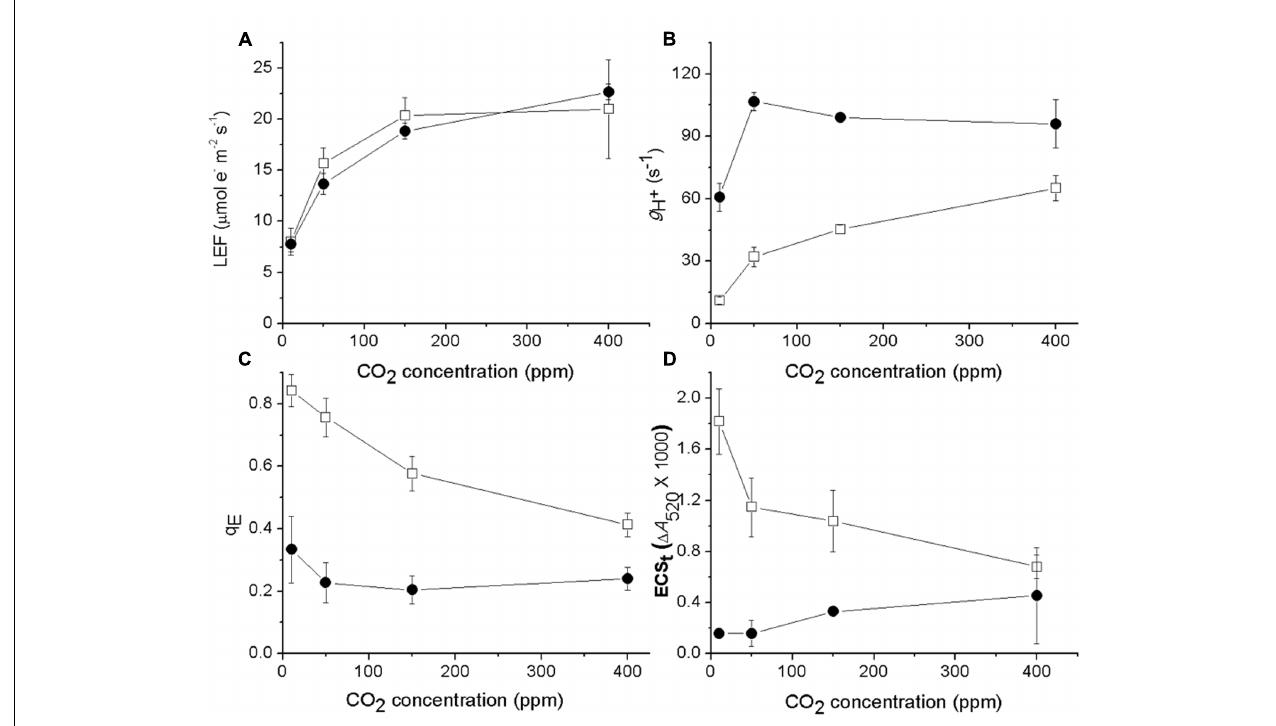
FIGURE 2 | Effects of CO 2 levels on LEF (A) , g H + (B) , q E (C) , and ECSt (D) with steady-state illumination at 100 µ mol photons · m − 2 · s − 1 . Open squares and closed circles represent Col-0 and cfq, respectively.